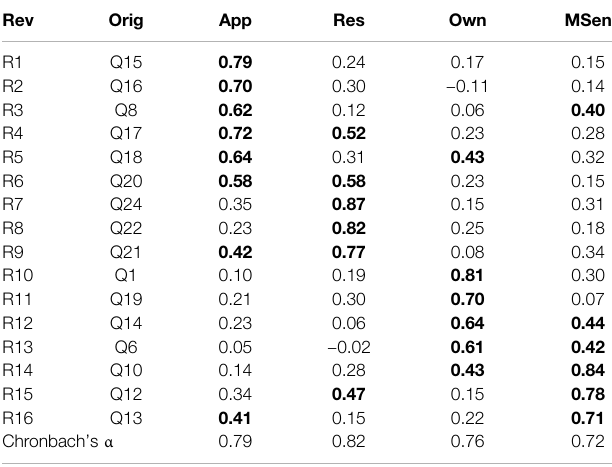
TABLE 3 | The structure matrix of the PCA analysis after performing oblique rotation on 16 questions. Values greater than |0.4| are in bold Rev Orig App Res Own